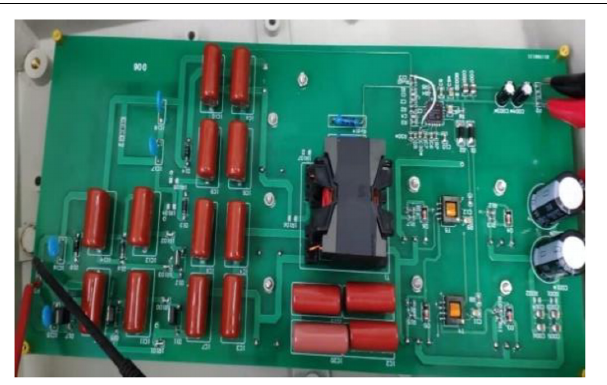
FIGURE 11 | High-voltage power module